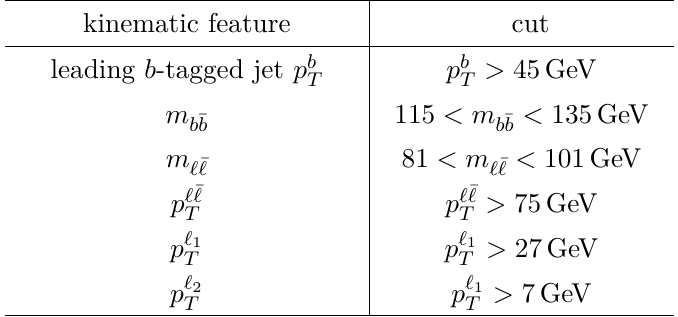
Table 5. Selection and acceptance cuts imposed on the final-state particles of the hZ → b ¯ b‘ + ‘ −